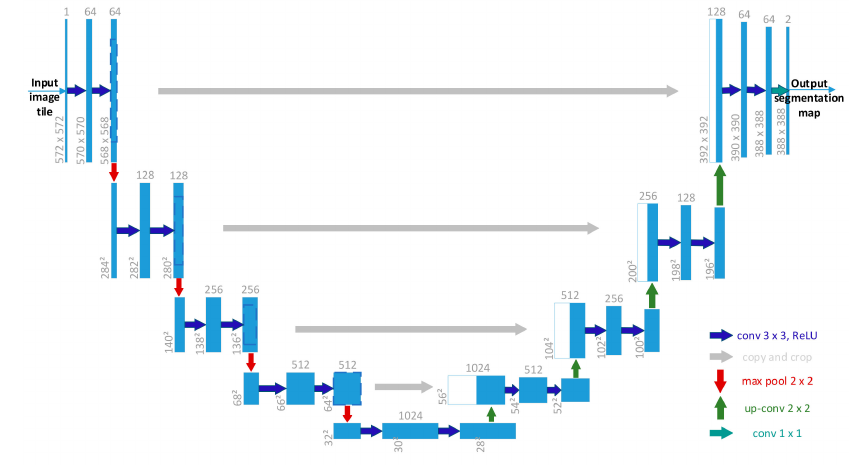
Figure 1. U-Net model structure